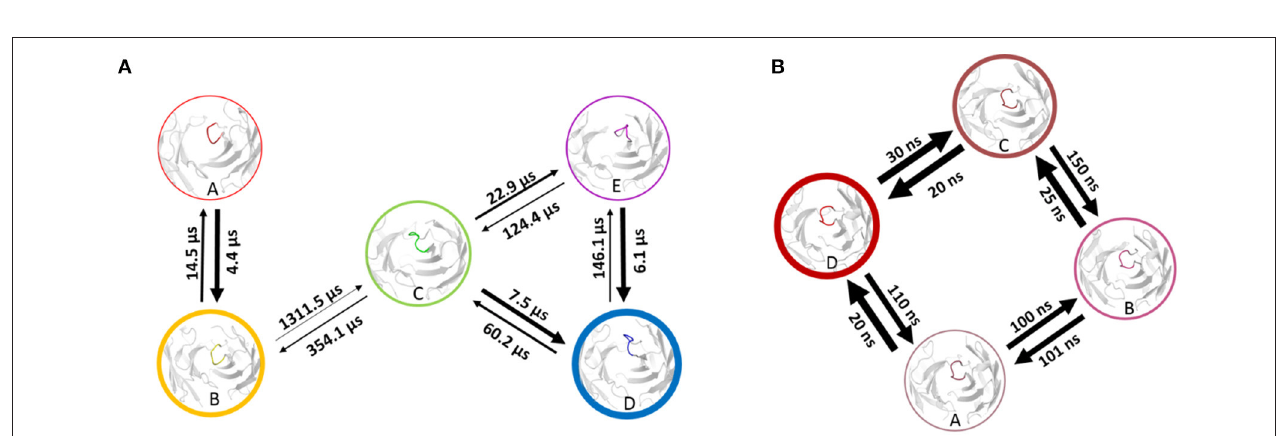
FIGURE 2 | Markov-state transition timescales for the naïve (A) and the matured (B) antibody. The thickness of the circles represents state probabilities, while the width of the arrows relates to the strongly varying transition timescales.